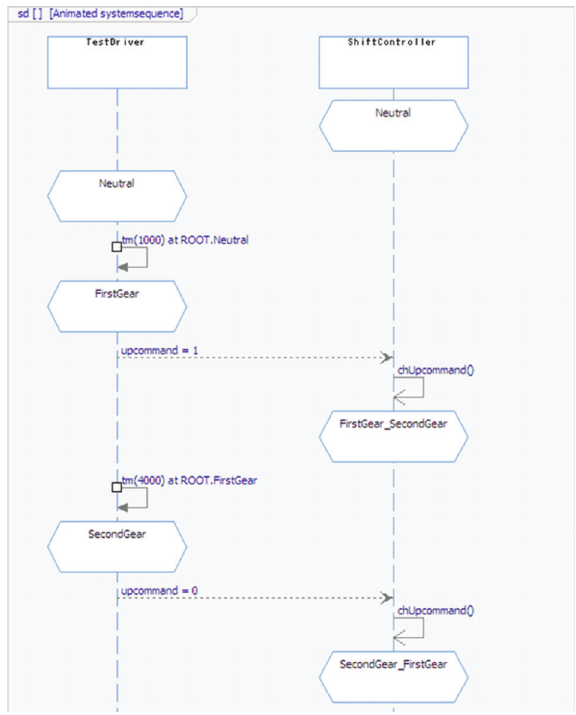
Figure 22: Part of generated sequence